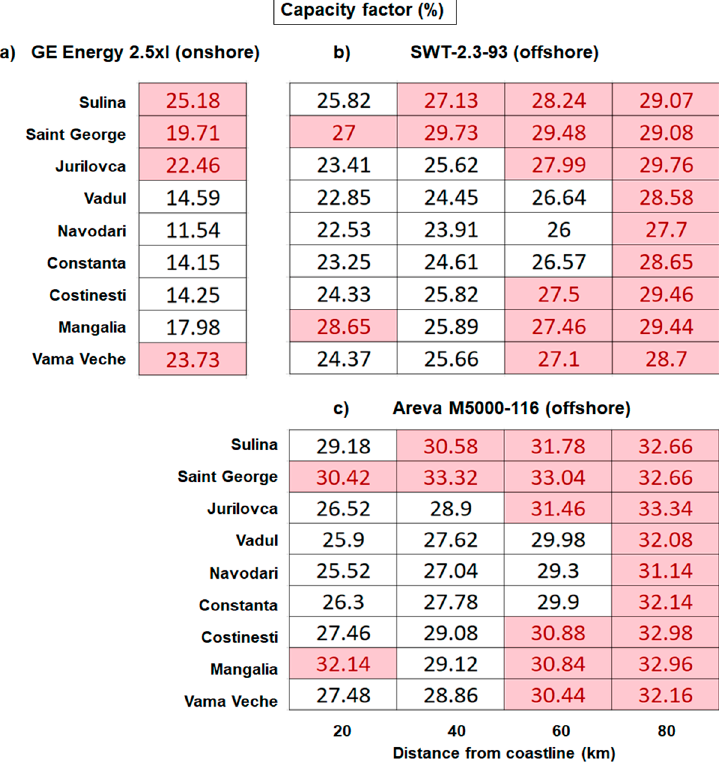
Figure 9. Capacity factor corresponding to: ( a ) GE Energy 2.5xl; ( b ) SWT-2.3-93; ( c ) Areva M5000-116.